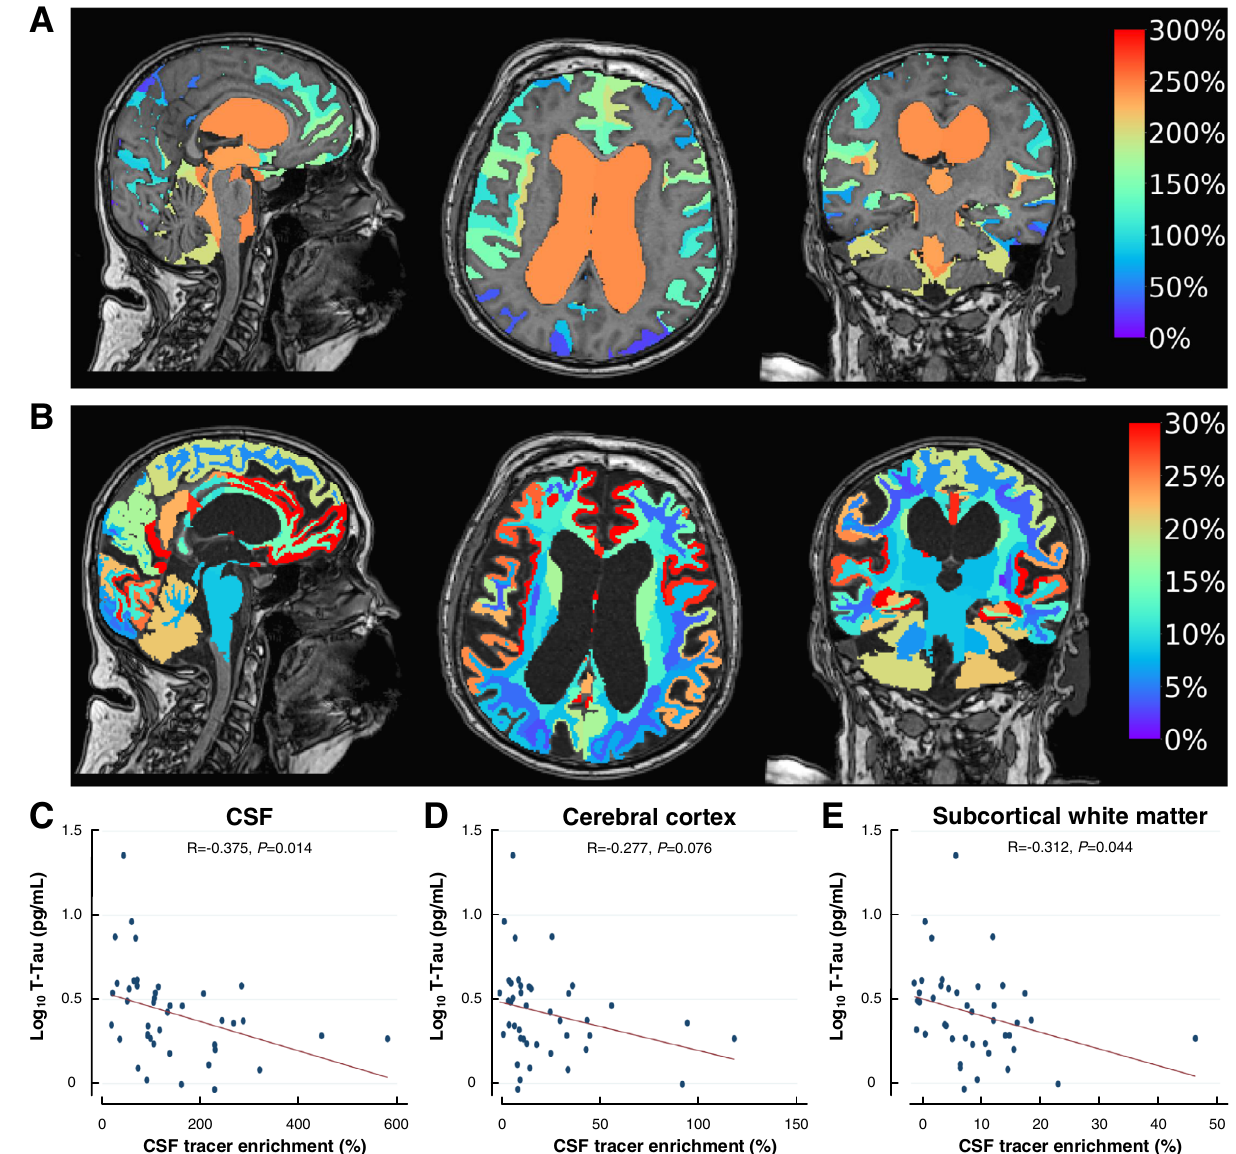
Fig. 1 | Association between clearance of a CSF tracer and plasma concentra- tions of log 10 T-tau in the iNPH cohort ( n =54). A The percentage changes in tracer withinCSF(ventricularand subarachnoidspaces) of the iNPH cohort at24h compared to Pre are shown in sagittal, axial and coronal planes. Higher values indicate reduced clearance. B The percentage change in tracer enrichment within the brain (tracer in CSF subtracted) of the iNPH cohort at 24h is shown in the sagittal, axial, and coronal planes. The panels ( A , B ) show the average change in tracer enrichment at the group level. In lower panels ( C – E ) are shown correlations